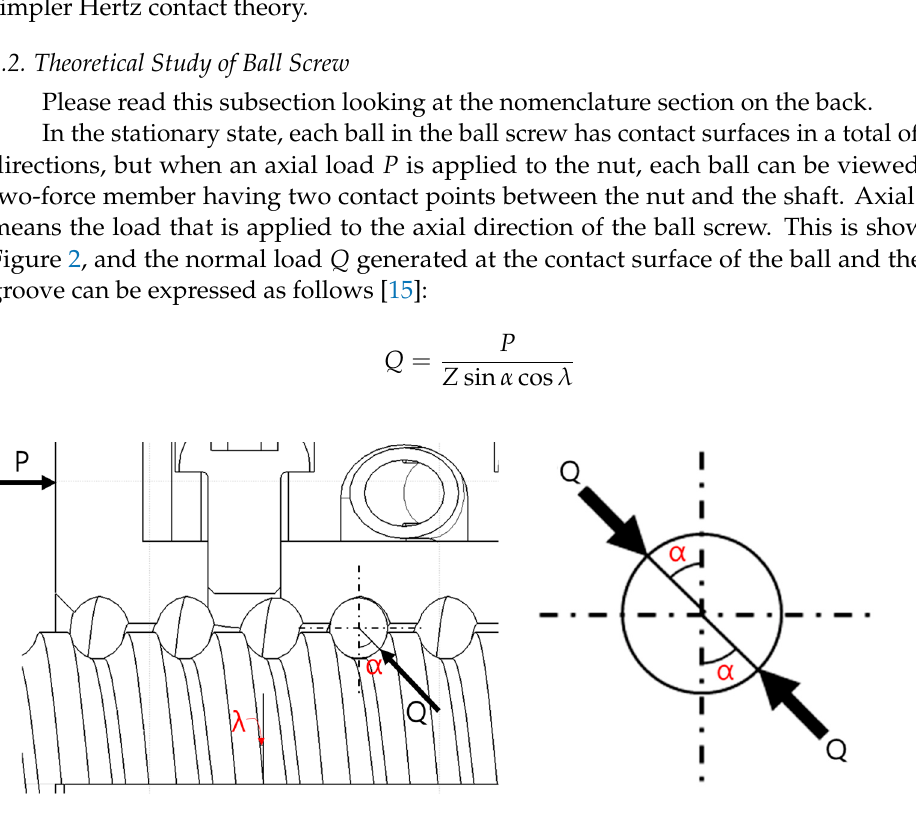
Figure 2. Normal contact load direction of ball